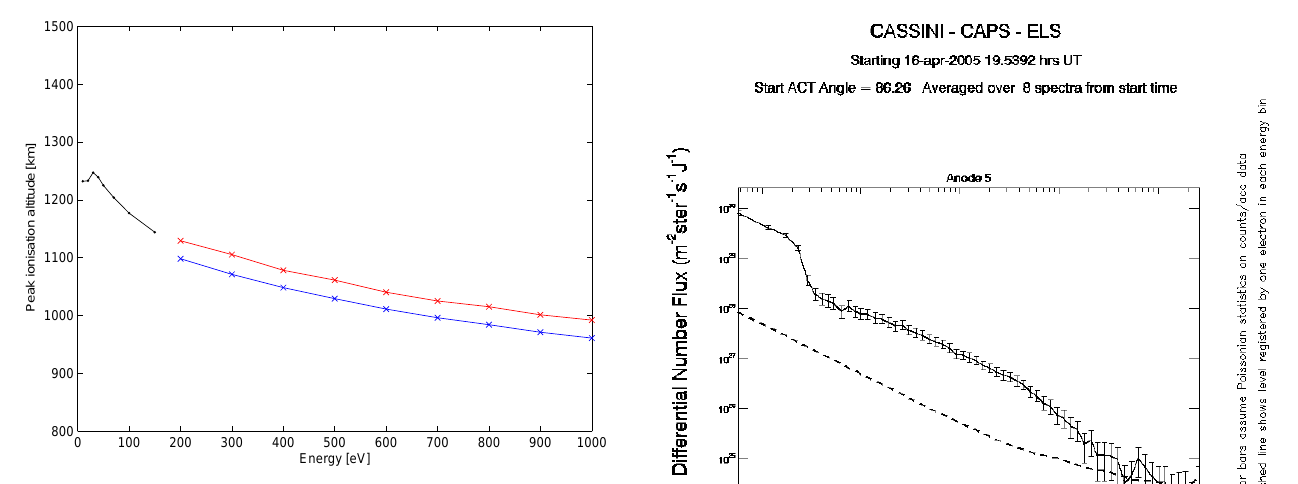
Fig. 8. Peak altitudes for the ionisation rates. Values corresponding Fig.8. Peakaltitudesfortheionisationrates. Valuescorrespondingtoaunidirectionalbeam(blue),anisotropic to a unidirectional beam (blue), an isotropic distribution (red) and distribution(red) andresults from the electrontransport code (black). results from the electron transport code (black).